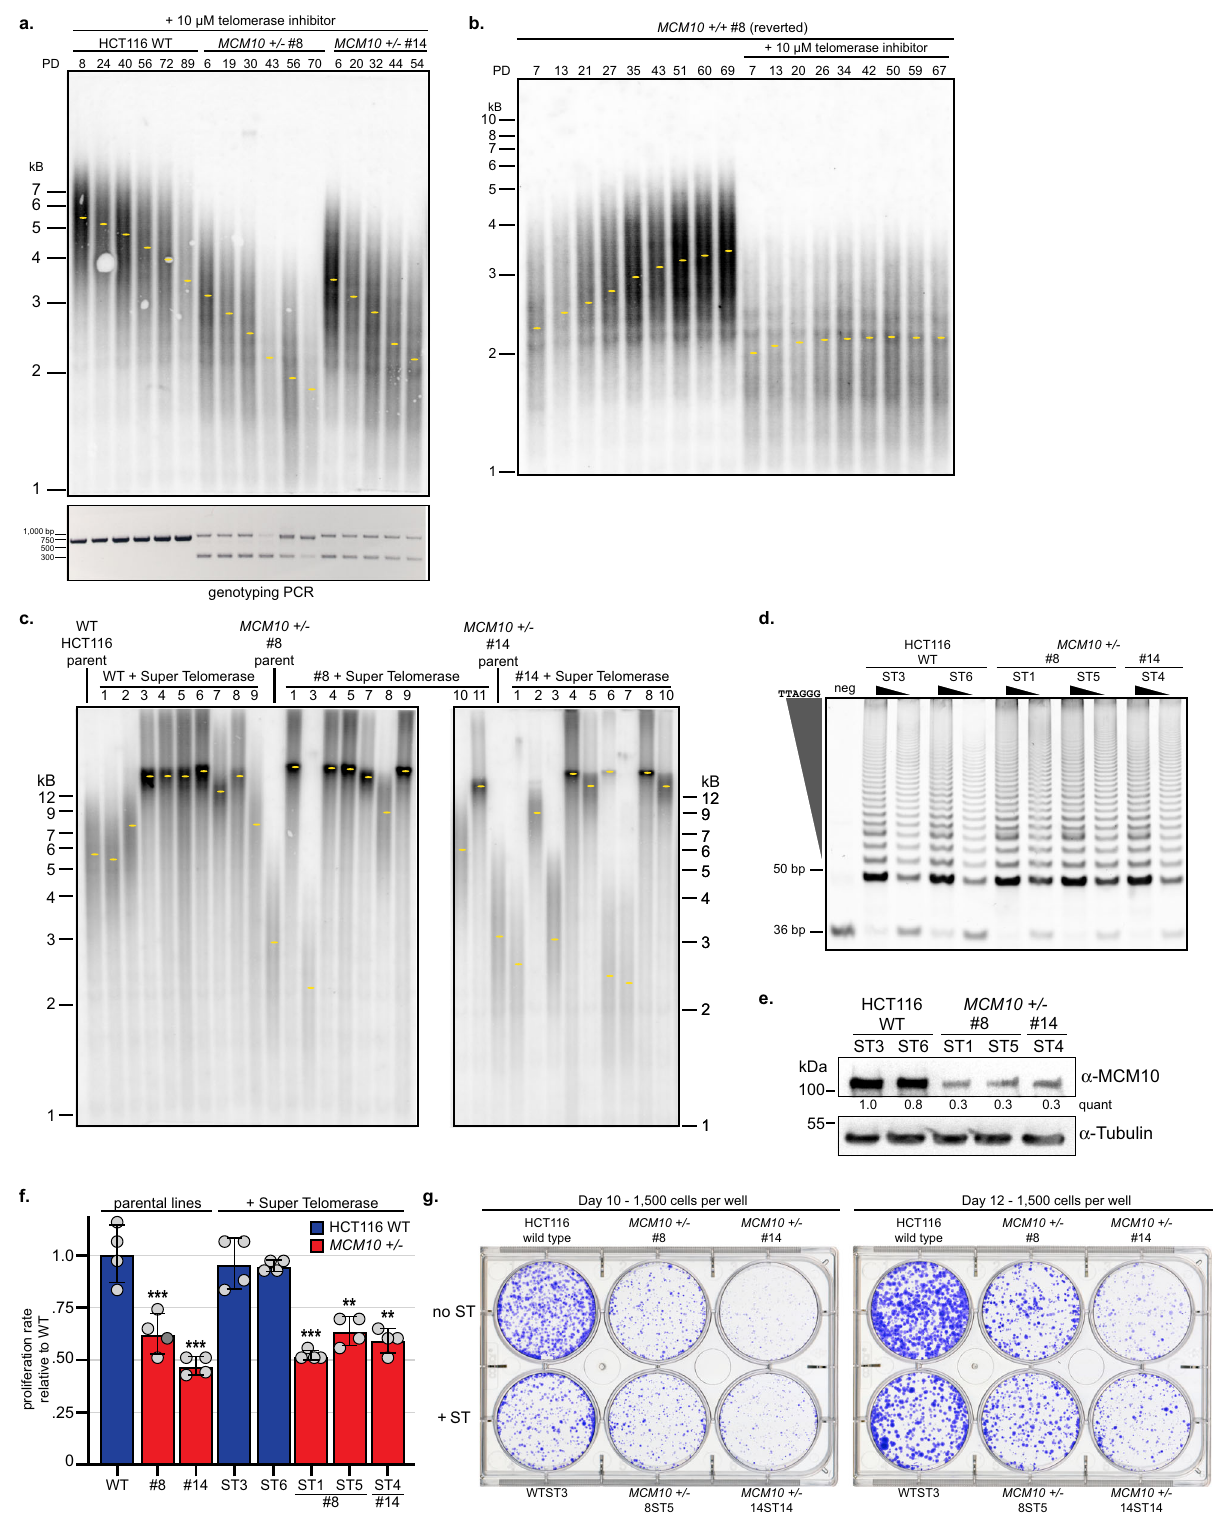
forks to rescue DNA synthesis and promote MCM10 + /- cell viability (Fig.